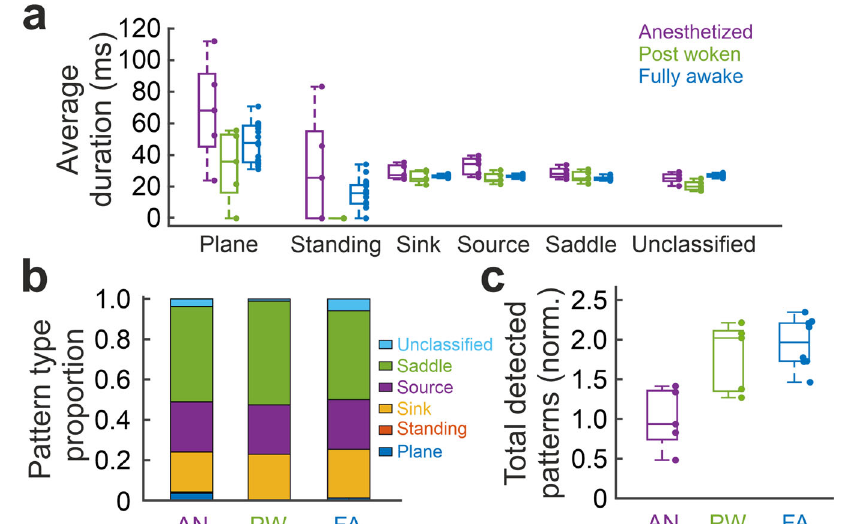
Fig. 5 | Spatiotemporal dynamics of wave patterns. a Boxplots for average duration of the different wave patterns at different brain state conditions. b Proportion of the different wave patterns at different brain state conditions. c Normalized total detected pattern numbers at different brain states. AN: anes- thetized, PW: post woken and FA: fully awake. For AN, total pattern numbers for eachtrialarenormalizedtothemeantotalpatternnumberacrosstrialsatANstate.